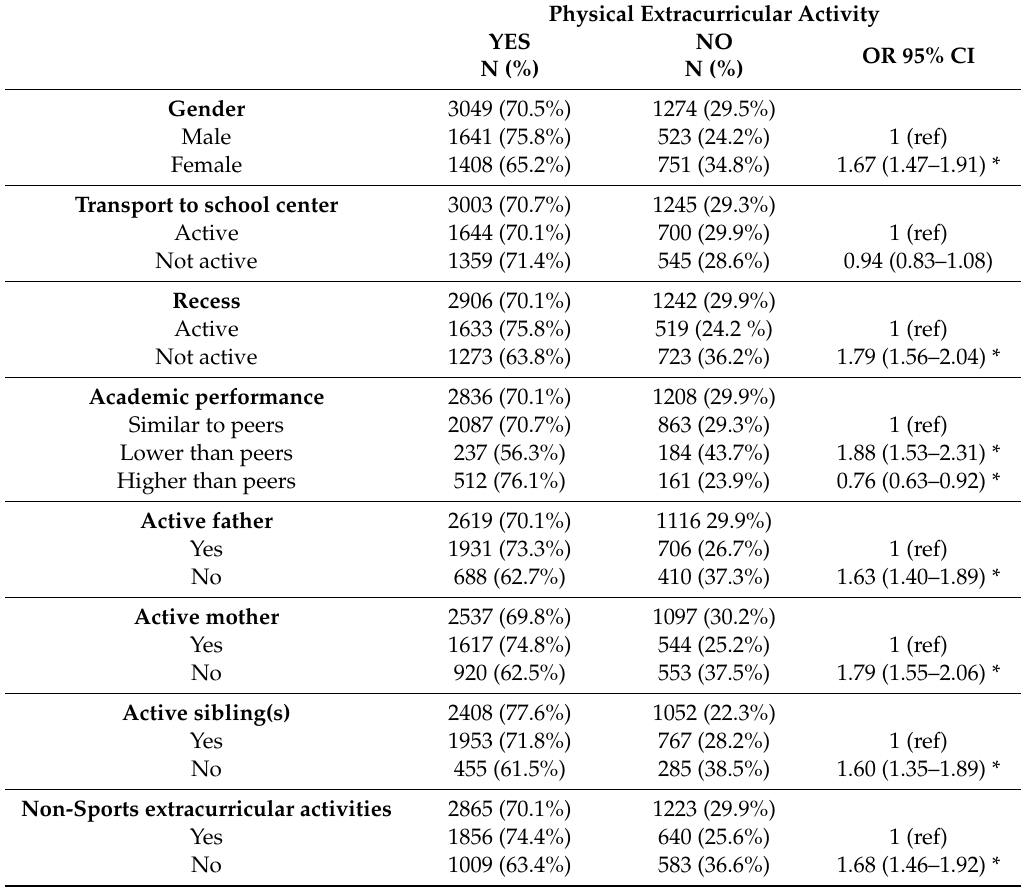
Table 2. Relationship between the variables examined and the extracurricular physical activity in primary education (from 7 to 12 years